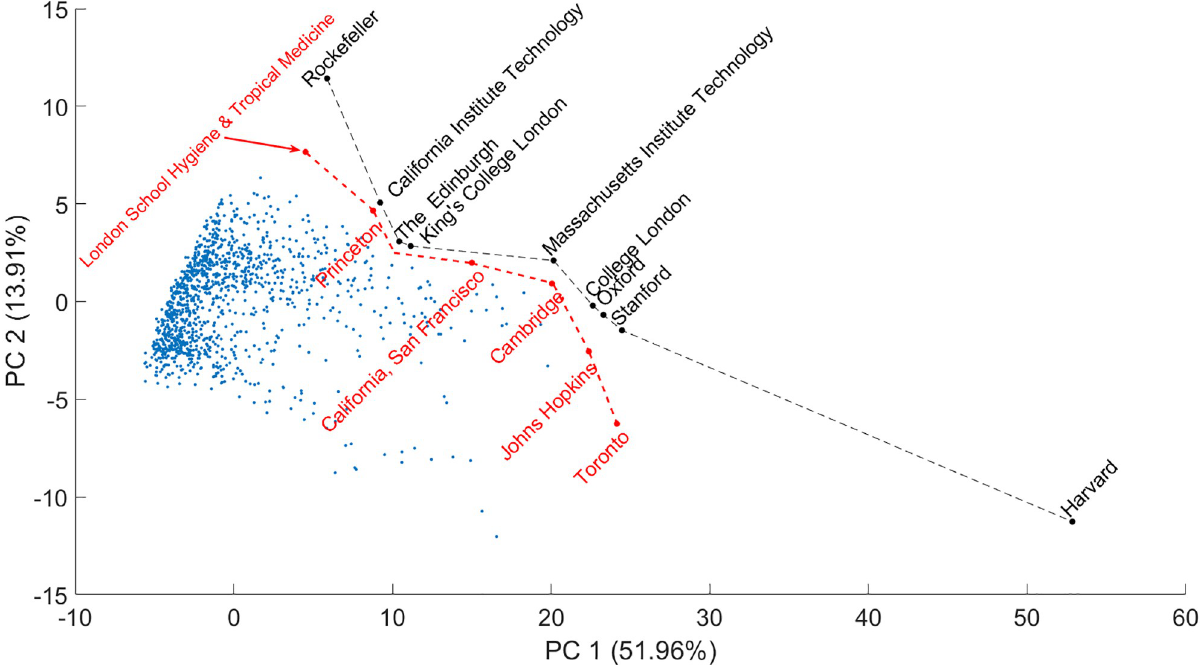
Fig 8. PCA-based Pareto front. In the first PC, objectives that focus on quantity are dominant, while the second PC promotes a high proportion of publications that perform well as scientific indicators, open-access as well as in terms of collaborations. Rockefeller University is a small private university but has an outstanding proportion of objective values compared to other, more robust universities. At the other end is Harvard University, where resources are available to create an immense amount of publications. Note that only universities from the Anglosphere are on the first two Pareto